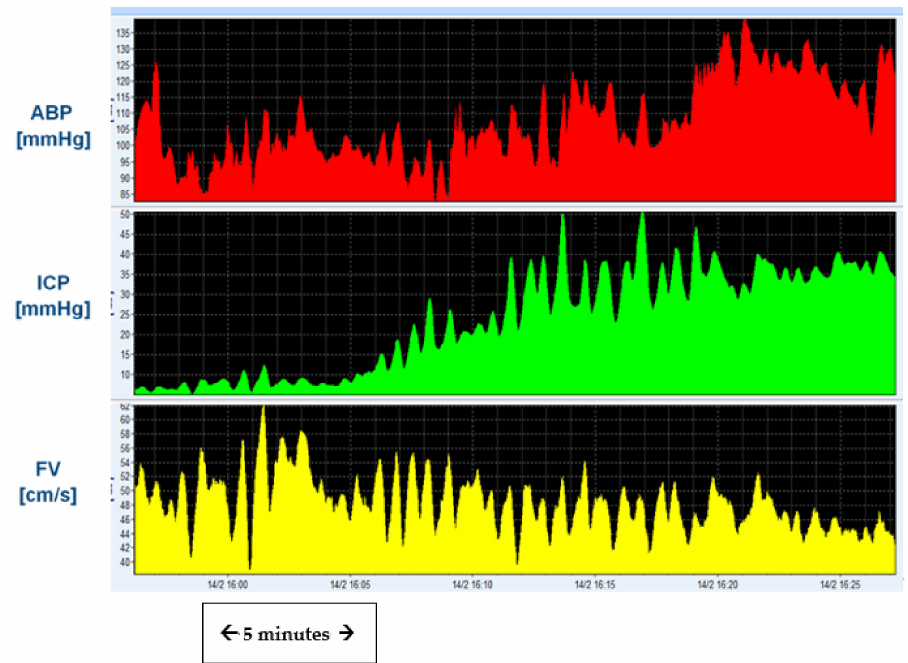
Figure 8. Slow waves of ICP, arterial blood pressure and cerebral blood flow velocity. Simultaneous recording of mean arterial blood pressure (ABP), ICP, and transcranial doppler derived flow velocity (FV) recording through the middle cerebral artery. Note the similarities in frequency and synchronicity in slow waves of FV and ICP. Cerebral autoregulation indices can be calculated from both ICP and ABP, as well as FV and CPP